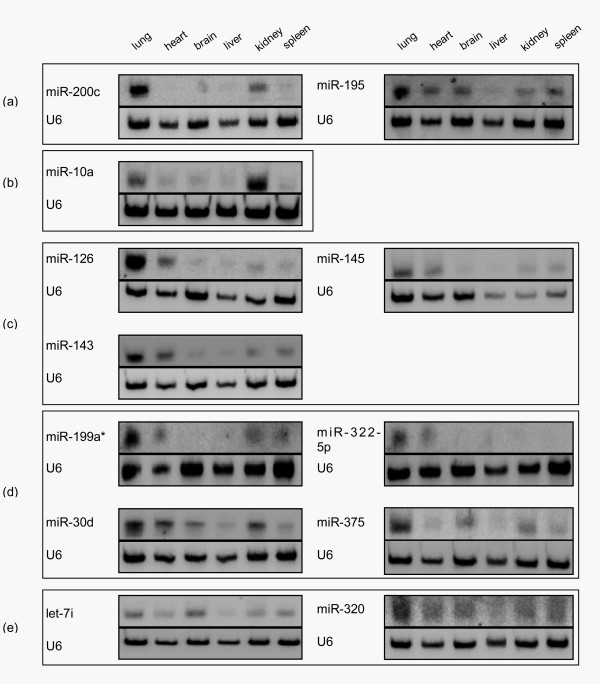
Northern blot validation. 15 μg total RNA was separated on a denaturing 15% PAGE gel. The 32P labeled probes for the microRNA were hybridized to the membrane overnight. The U6 snRNA was probed as the loading control after the hybridization of microRNA probes. (a) lung-specific miRNAs; (b) kidney-specific miRNAs; (c) co-expressed miRNAs in the lung and heart identified by HSD; (d) miRNAs highly expressed in the lung and/or the heart. (e) commonly expressed miRNAs.